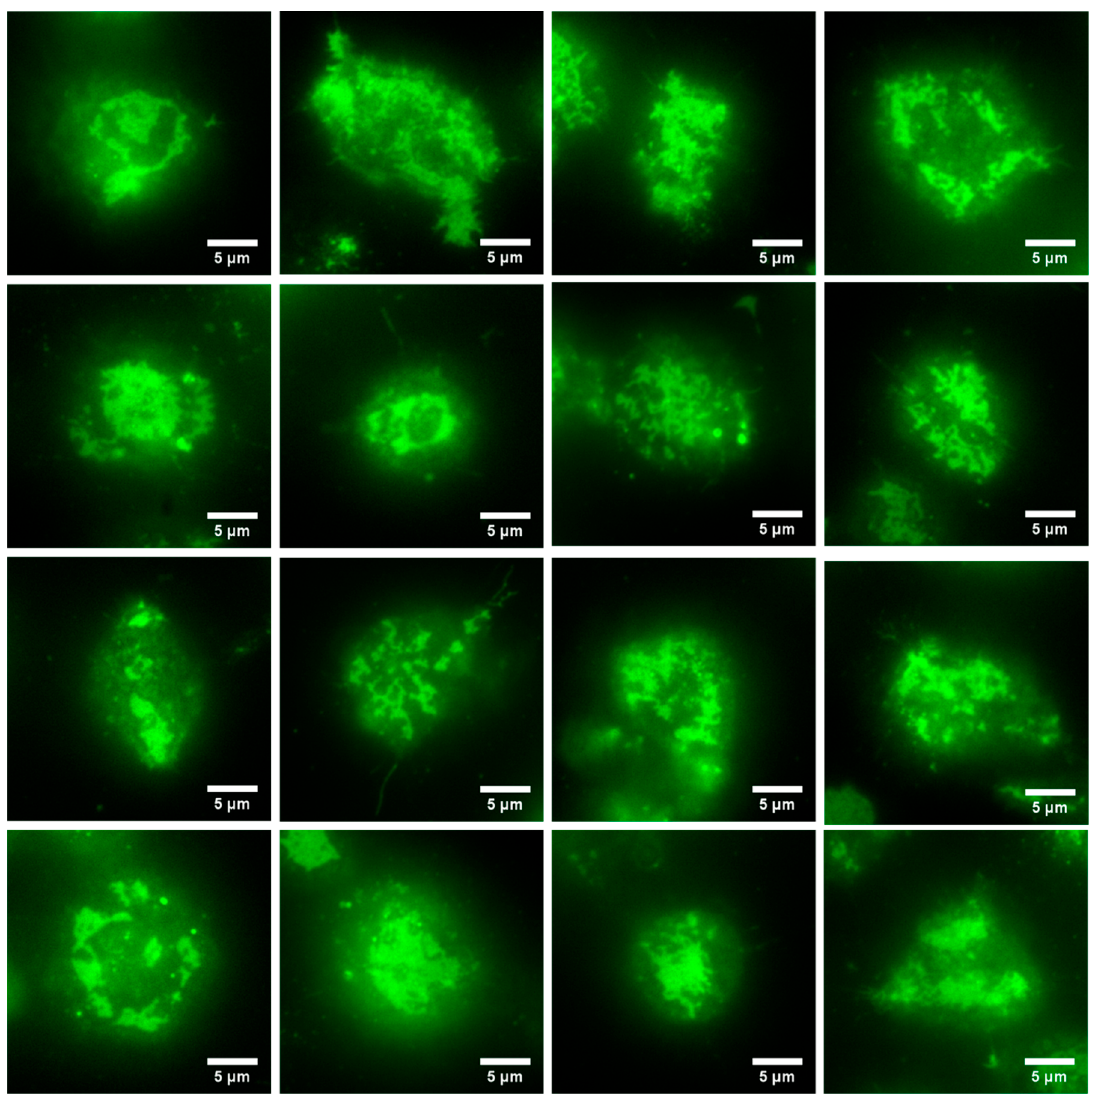
Figure 4. Gallery of images of RBL-2H3 cells labeled overnight with IgE-488 in contact with a supported lipid bilayer containing a lipid derivatized with the IgE ligand DNP. After 10–15 min of contact at 37 °C, we observed a wide variety of patches of IgE-488 labeled Fc ε RI. Images were acquired with the Zyla 4.2+ sCMOS camera.